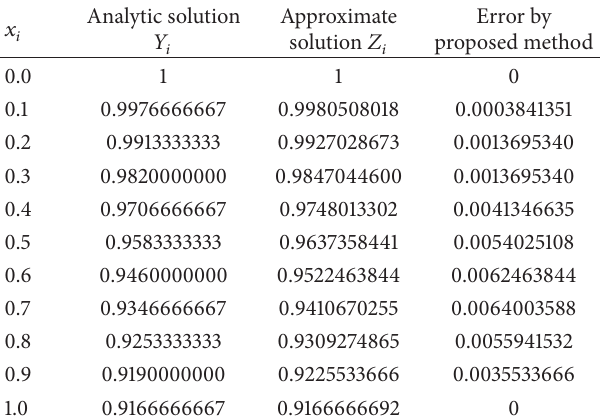
Table 5: Numerical results of Example 4: 𝑘 = 1/2 and ℎ = 10 −1 .